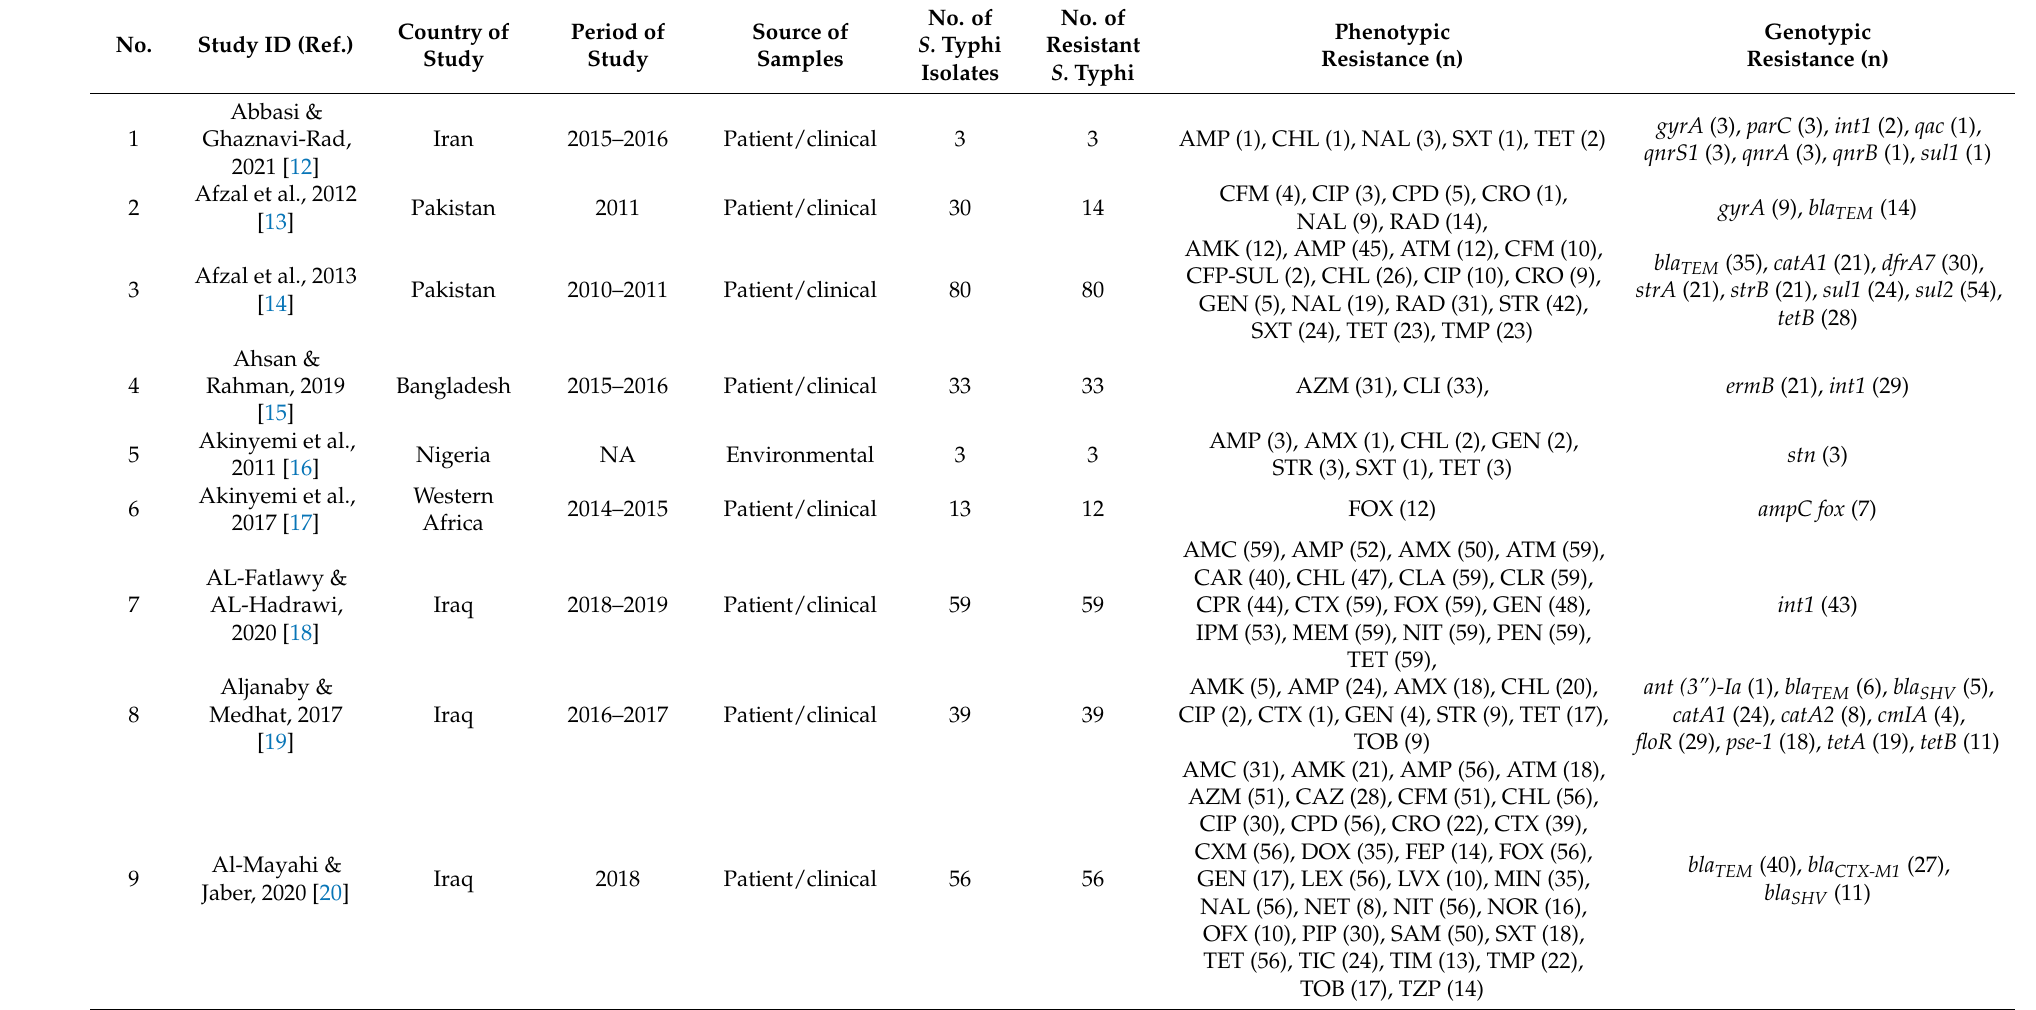
Table 1. Major characteristics of the included studies in the systematic